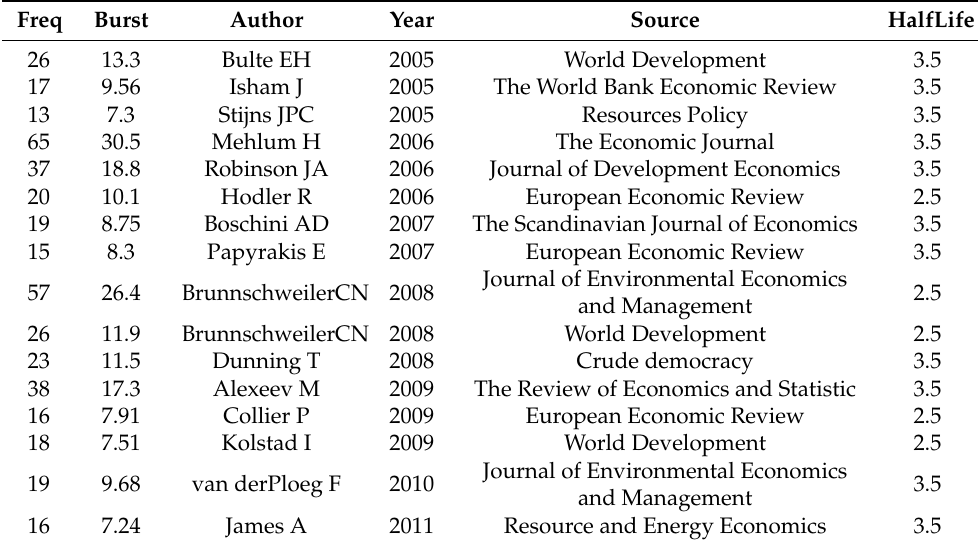
Figure 23. A timeline visualization of the Cluster 1 co-citation network (using Citespace 5.7.R4). Table 7. Exploration and summary of Cluster 1. Table 7. Exploration and summary of Cluster 1. Table 7. Exploration and summary of Cluster